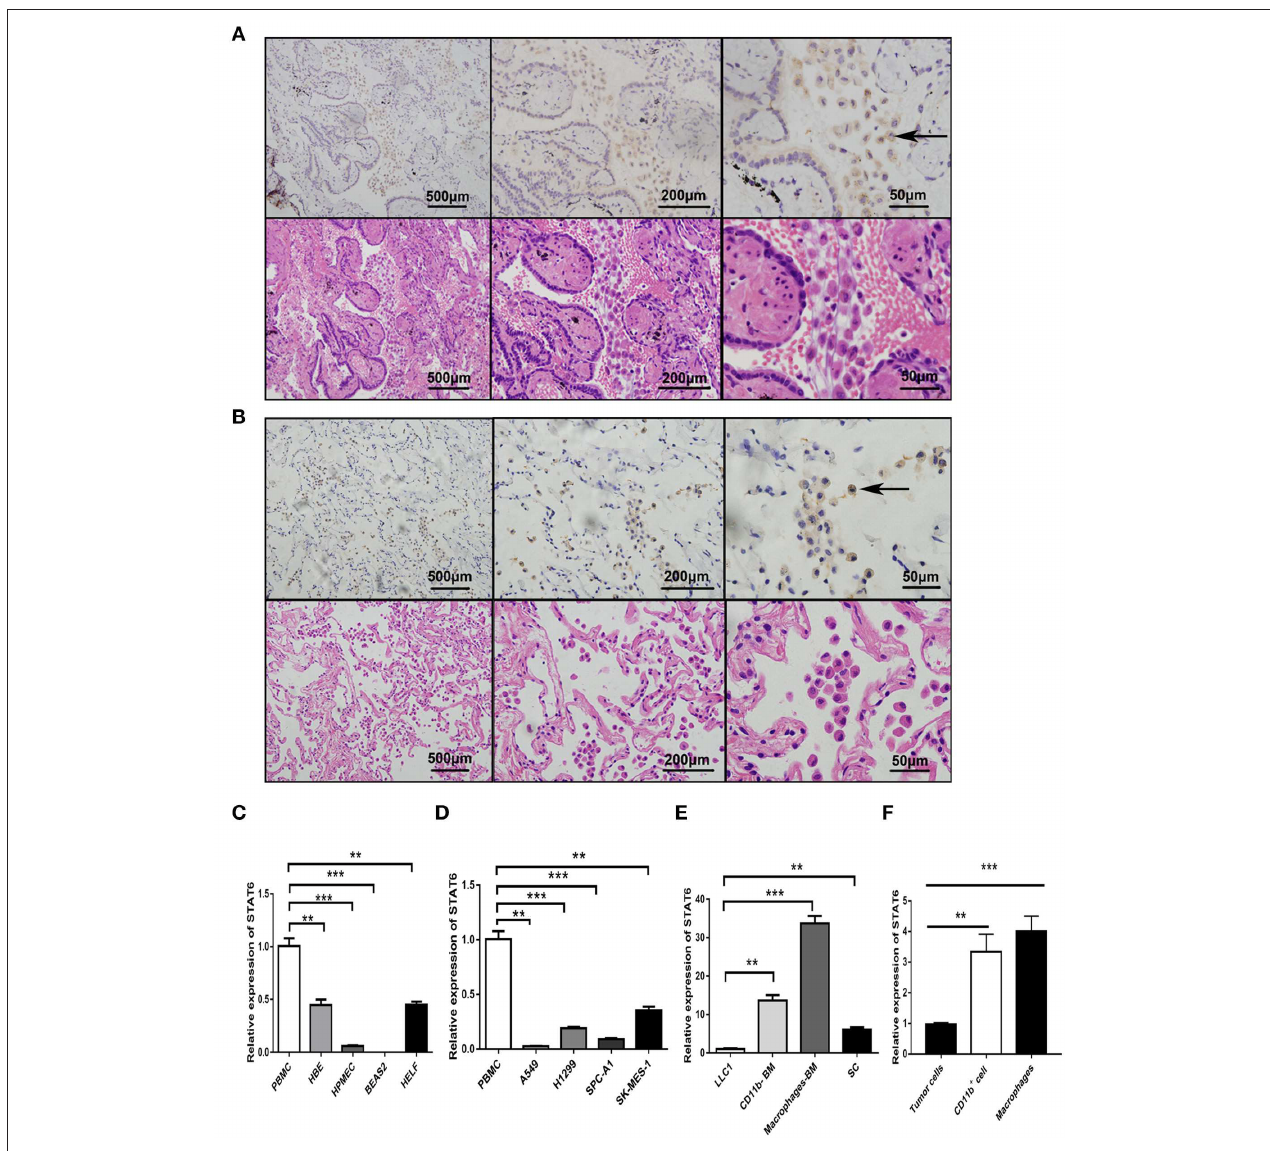
FIGURE 1 | Expression of signal transducer and activator of transcription 6 (STAT6) in lung cancer cells. (A) Immunohistochemical (IHC) staining of STAT6 in lung squamous carcinoma and corresponding hematoxylin and eosin (H&E)-stained images. (B) IHC staining of STAT6 in lung adenoma carcinoma and corresponding H&E-stained images. (C) Comparison of STAT6 mRNA expression between peripheral blood mononuclear cells (PBMCs) and human-derived lung cells. Human-derived lung cell lines bought from ATCC, including normal human bronchial epithelial (HBE), human pulmonary microvascular endothelial cell (HPMEC), human embryonic lung fibroblast (HELF), and human bronchial cell line BEAS2. (D) Comparison of STAT6 mRNA expression between PBMC cells and lung cancer-derived cell lines. (E) Comparison of STAT6 mRNA expression between immune cells and tumor cells. Spleen cells (SC) were obtained from 6-week old BALB/c mice and removed red blood cells. CD11b + cells and macrophage cells were obtained from bone marrow-derived cells of the same mice after removing red blood cells. (F) Comparison of STAT6 mRNA expression between cells. Tumor cells separated from primary tumor tissue induced by urethane, and CD11b + cells and macrophages from the bone marrow of WT mice after urethane inoculation (at time point of 6 months). Data are presented as mean ± SD of one representative experiment. Similar results were seen in three independent experiments. ** P < 0.01, *** P <